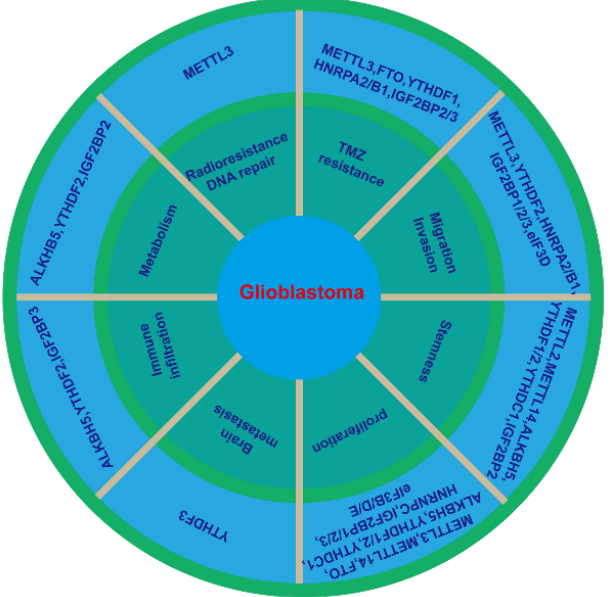
Figure 2. m 6 A regulator and the hallmarks of glioblastoma. Abnormal expression of m6A writers, erasers and readers in glioblastoma affects at least eight of the hallmarks: cell proliferation, stemness, migration and invasion, TMZ resistance, radioresistance and DNA repair, metabolism, immune infiltration, and brain metastasis. Table 1. List of reported functions of m 6 A regulatory proteins in glioblastoma.